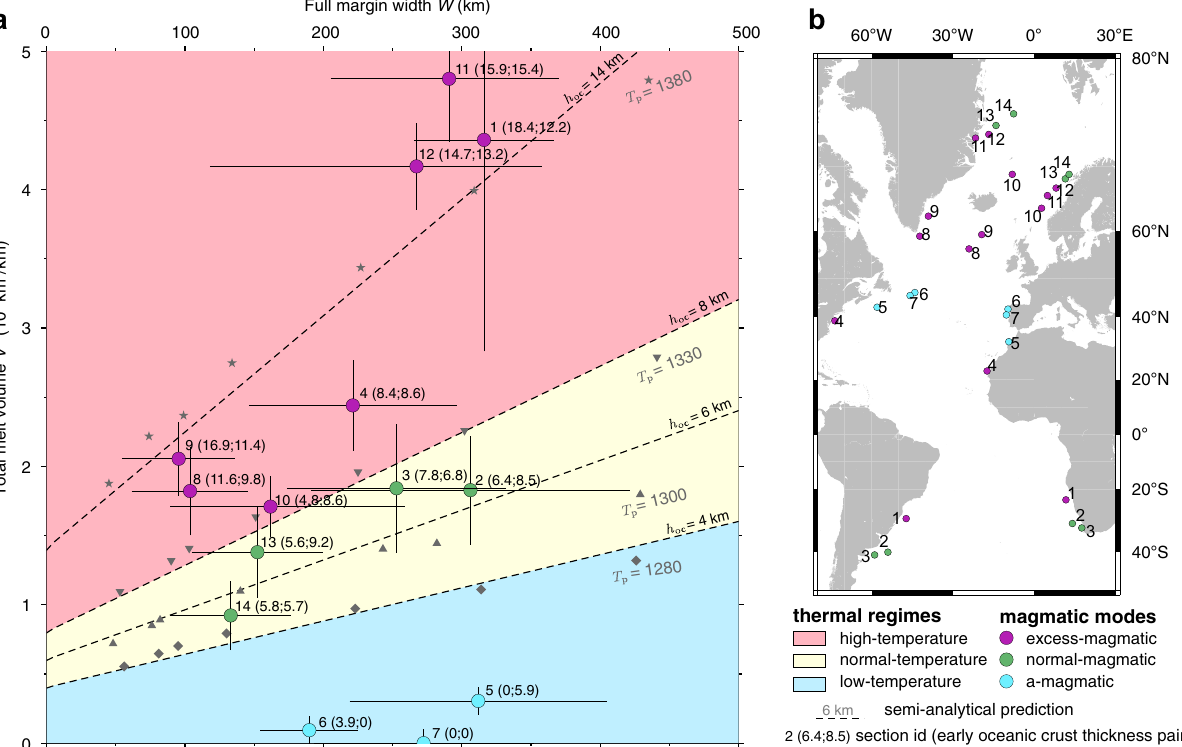
Fig. 6 Comparison of observed versus predicted melt volume and margin width. a Melt volume – margin width regimes. Grey symbols: model results at various T p labelled in degree Celsius; dashed lines: semi-analytical prediction for different oceanic crust thickness in km. Filled regions show thermal regimes for low-temperature (light blue), normal-temperature (pale yellow) and high-temperature (pink). Colour dots: observation data (Table 1) for a- magmatic (blue), normal-magmatic (green) and excess-magmatic (magenta) modes, with their uncertainties explained in Supplementary Table 2. b Locations of conjugate rifted margins with colours shown in a . See Supplementary Figs. 5 – 7 and Supplementary Table 2 for details.